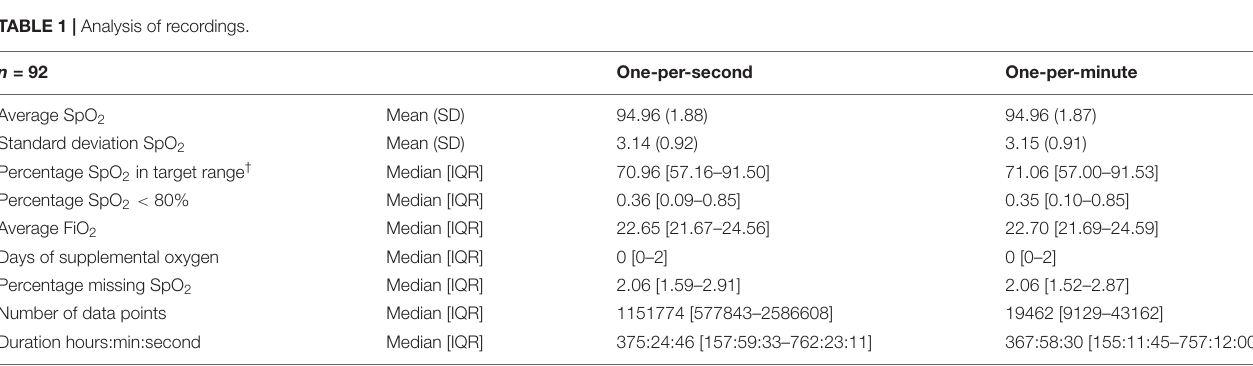
TABLE 1 | Analysis of